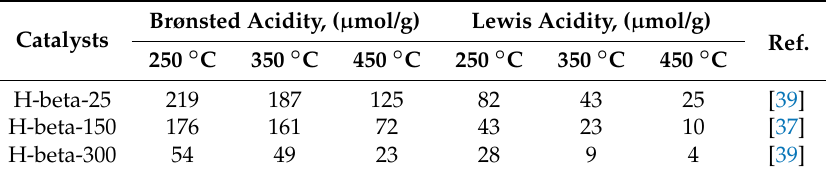
Table 2. Determination of Brønsted and Lewis acid sites in H-beta zeolite catalysts.